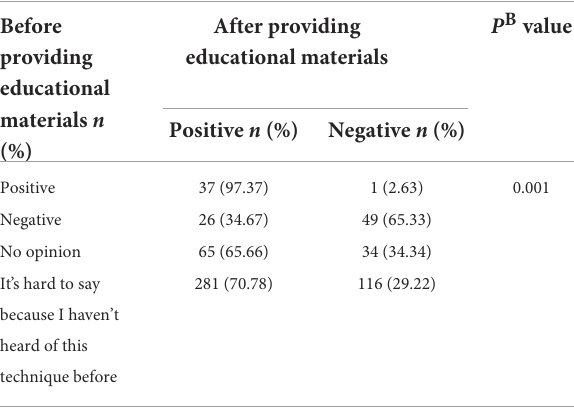
TABLE 3 Change in the attitudes of respondent toward food irradiation after providing educational